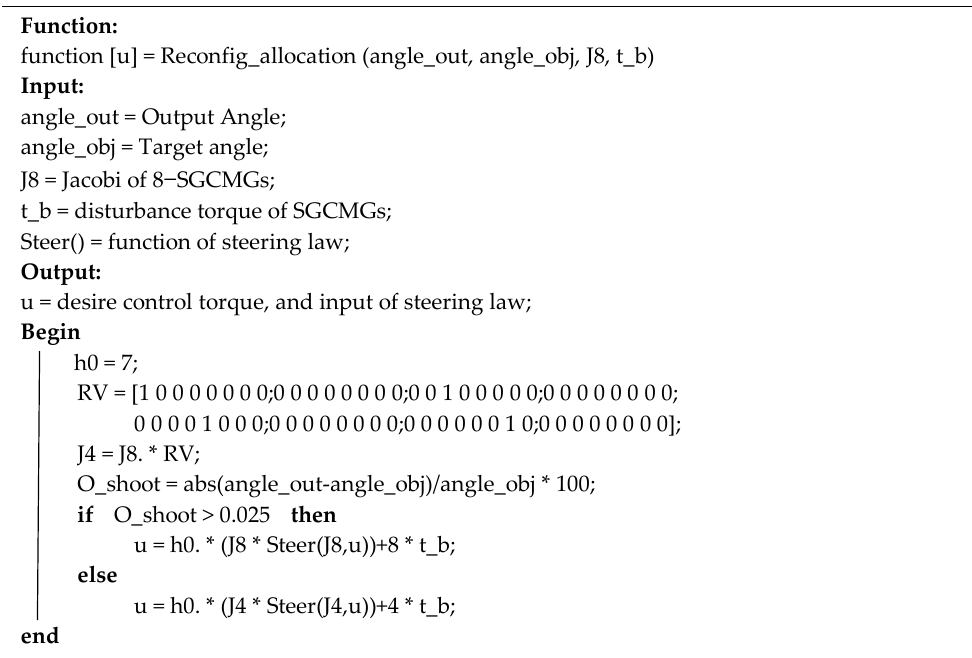
Figure 9. Reconfiguration of 8-SGCMGs into 4-SGCMGs. Table 6. Function of control and steering allocation. The process of output torque change that switches from 8−SGCMGs to 4−SGCMGs can be described as Function for Determining 8-SGCMGs Control Allocation